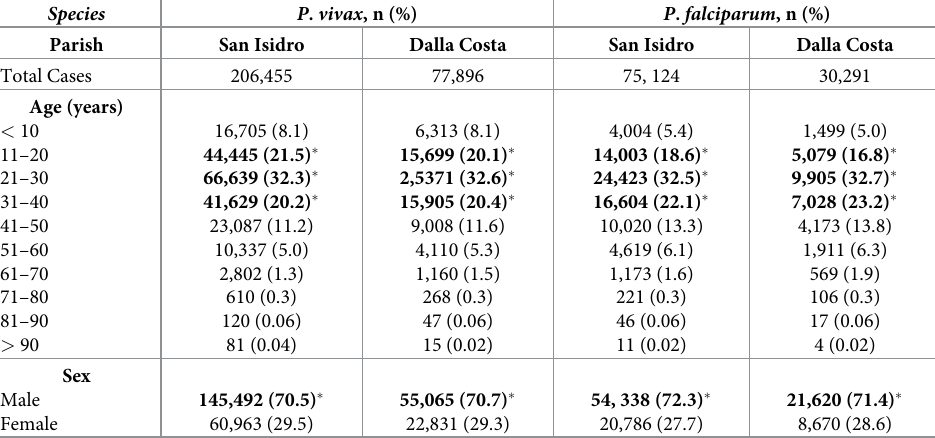
Table 1. Demographic characteristics of malaria patients 1 from two parishes of the Bolivar state (South-eastern Venezuela), during 2007–2017 period.